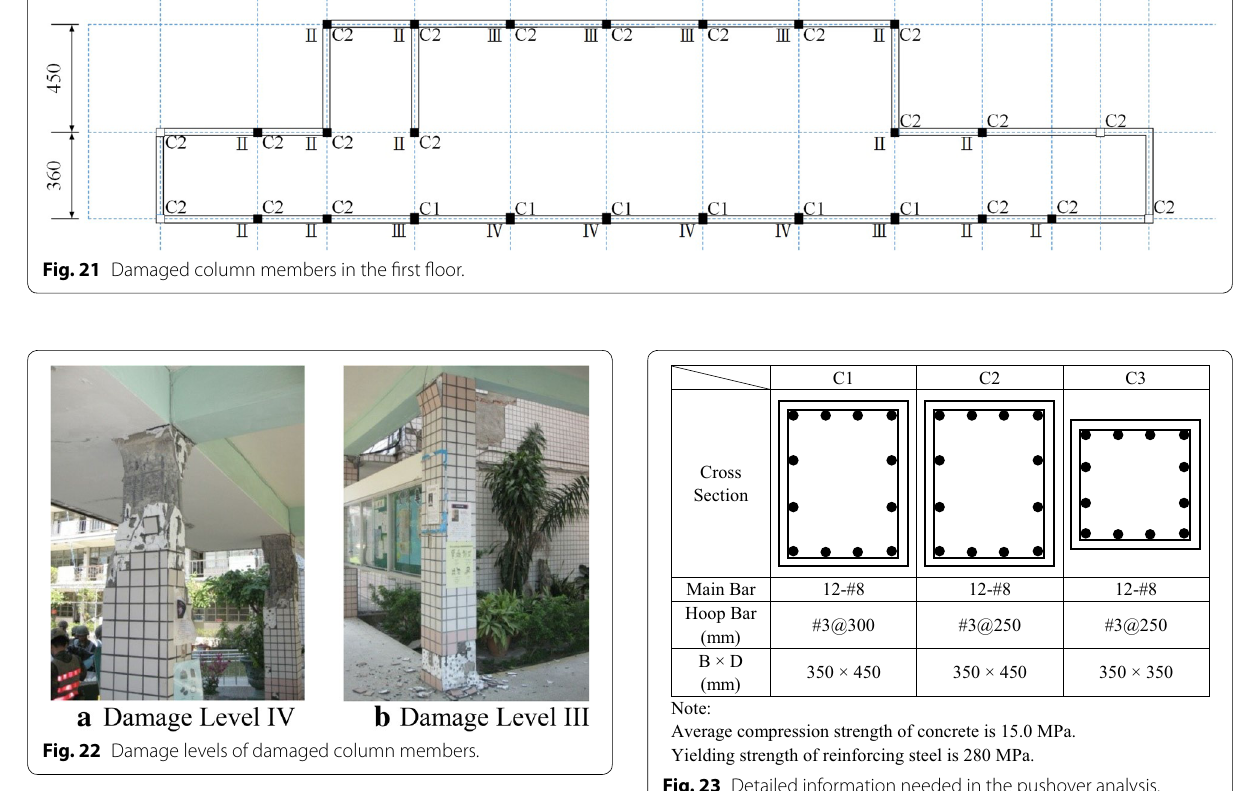
Fig. 23 Detailed information needed in the pushover